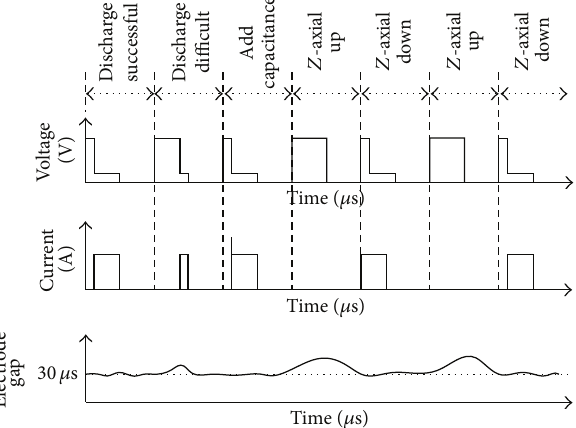
Figure 2: Schematic diagram with considerations of discharge difficulties, capacitor settings, and 𝑍 -axis settings.